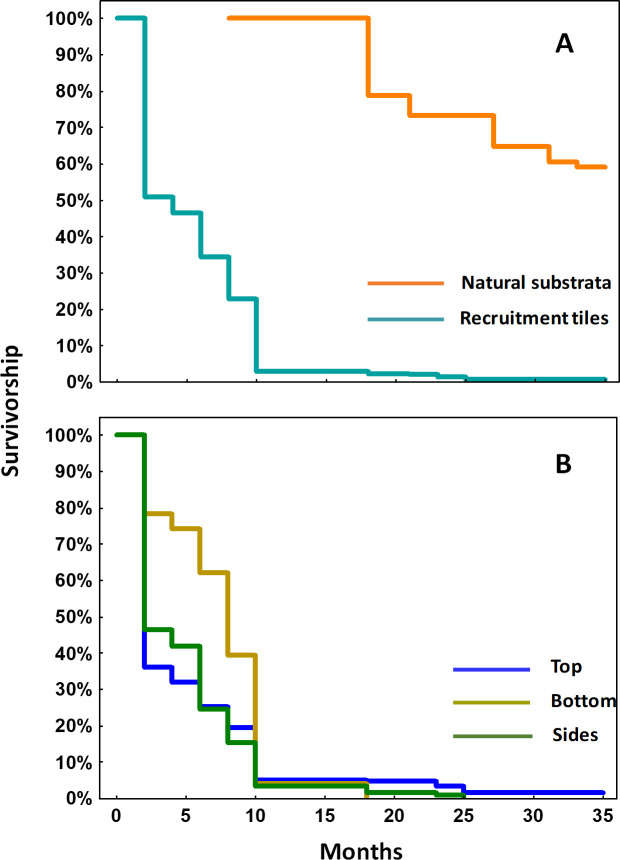
Kaplan-Meier survivorship for 35 months for (a) A. loripes recruits settled on tiles (N = 834), and for visible recruits on natural reef substrata starting at 8 months post-settlement (N = 72) (b) A. loripes recruit survivorship on different tile surfaces (N = 834).